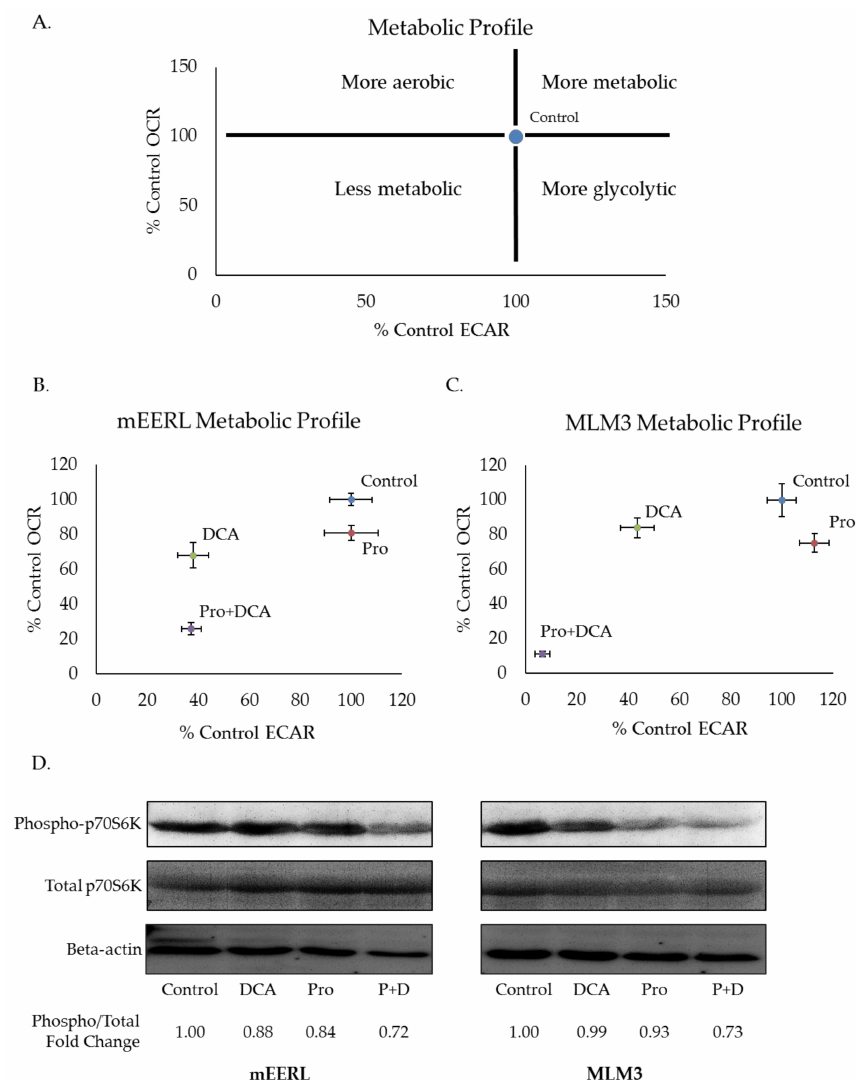
Figure 3. Propranolol synergizes with the glycolytic inhibitor dichloroacetate (DCA) to dramatically attenuate tumor cell metabolism and mTOR signaling. Metabolic profile schematic ( A ), representing possible shifts in metabolic phenotype compared to control. Metabolic profiles of mEERL ( B ) and MLM3 cells ( C ) treated overnight with propranolol (40 µ M) and/or DCA (10 mM). Values reflect the average of n = 3–5 independent biological replicates +/ − SEM. Values were adjusted for non-glycolytic acidification and normalized to total protein. Western blot ( D ) assessing mTOR activity via p70S6K phosphorylation in mEERL (left) and MLM3 cells (right) following overnight treatment with propranolol (40 µ M) and/or DCA (10 mM). Spot densitometry was used to calculate fold change in phosphorylated/total p70S6K signal intensity relative to control for each cell line. 2.4. The Combination of Propranolol and DCA Synergizes for Significant Anti-Cancer Activity in